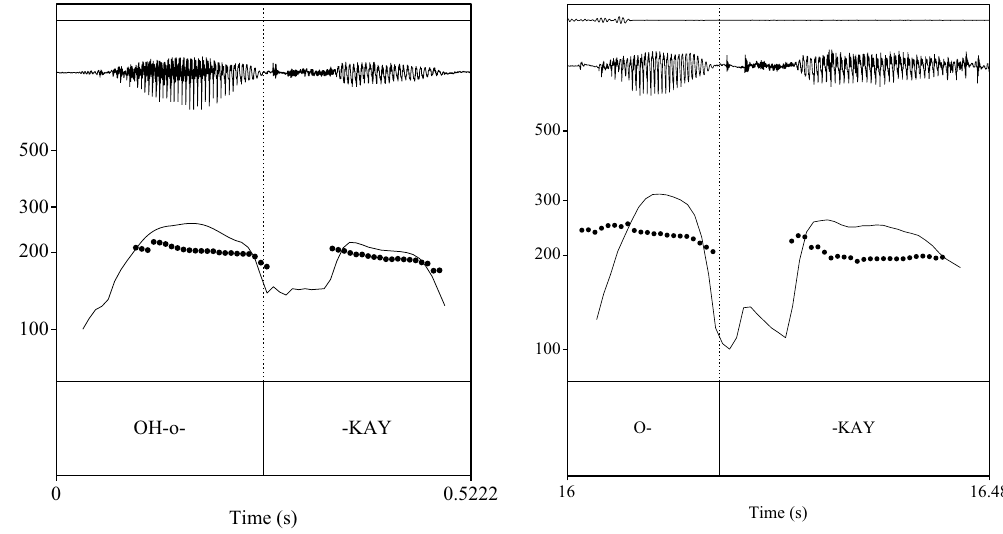
Figure 7: Pitch traces and intensity curves for line 19 ( left ) and line 11 ( right ) in Ex ( 10 ) “ Plastic container ”